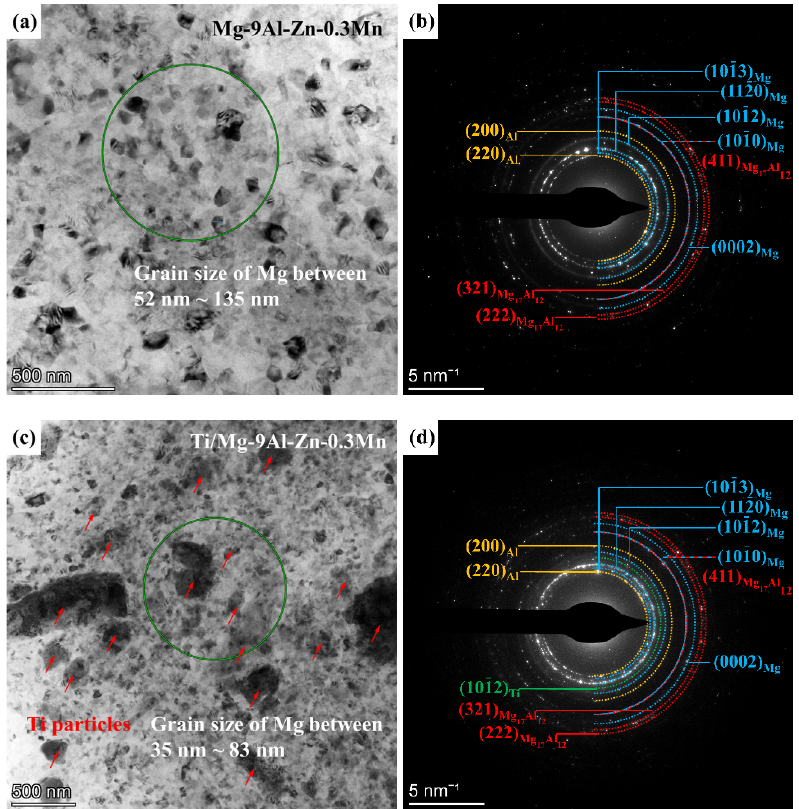
Figure 8. BF images and corresponding SAED results of milled Mg-9Al-Zn-0.3Mn ( a , b ) and Ti/Mg-9Al-Zn-0.3Mn ( c , d ).